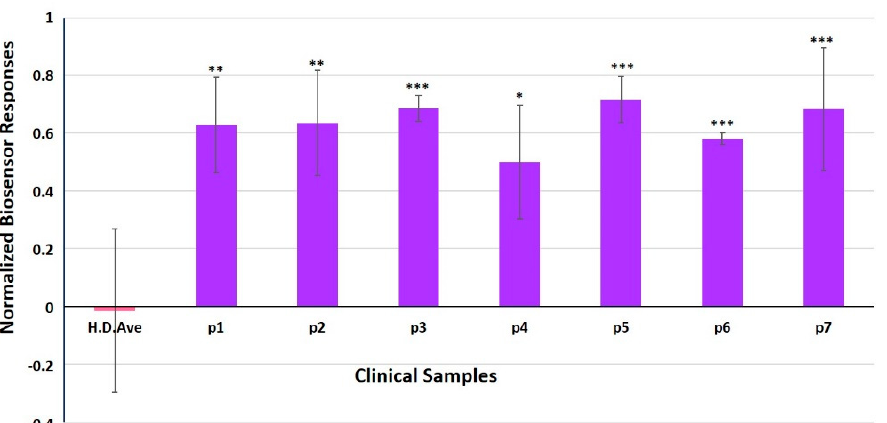
Figure 5. Normalized cell biosensor’s responses in 3D cultures against clinical samples from patients ( n = 7) and healthy donors (mean of 10 samples—pink column. Results are expressed as normalized biosensor responses ([control–sample response]/control). Significant differences (Student’s T -test) between normalized biosensor responses * < 0.05, ** < 0.01, *** < 0.001.